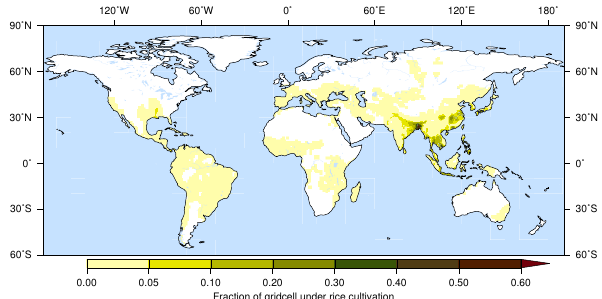
Fig. 4. Annual maximum fraction of land covered by rice fields (Leff et al., 2004).